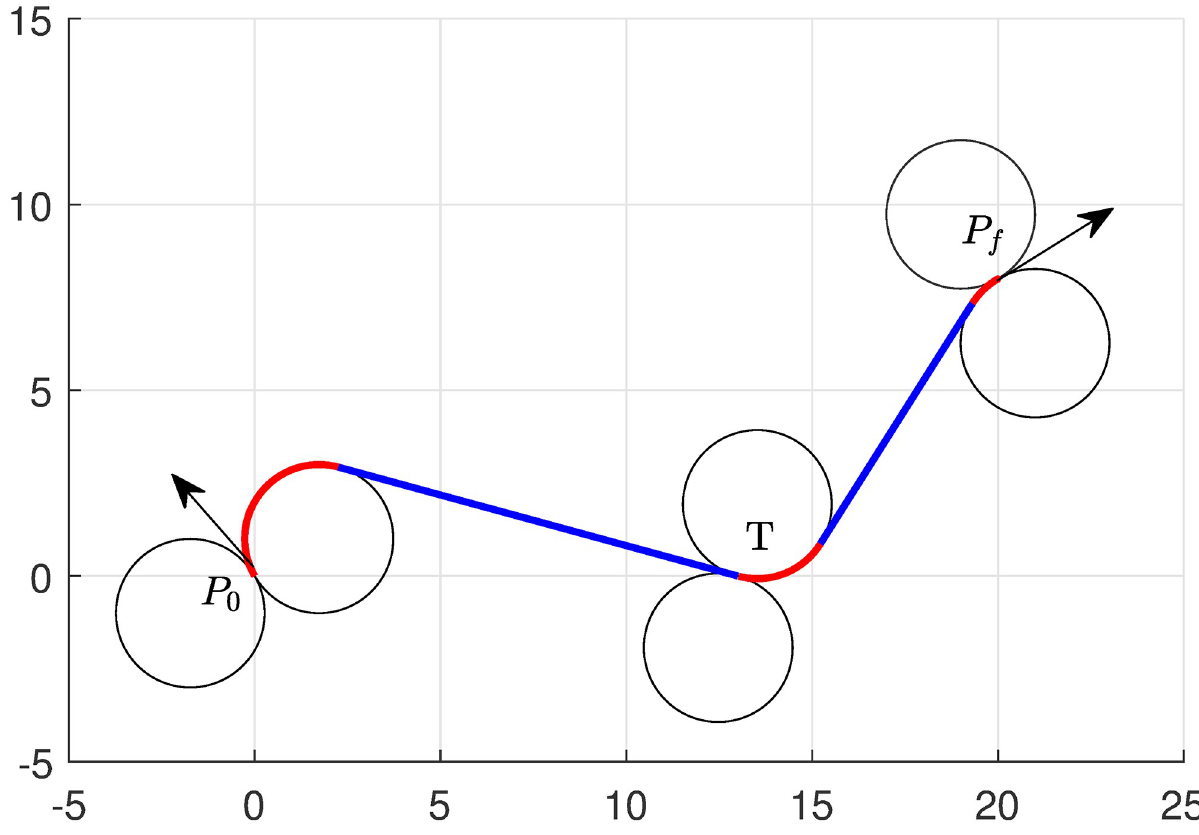
Fig 3. Minimum path of UAV with single target touring of type